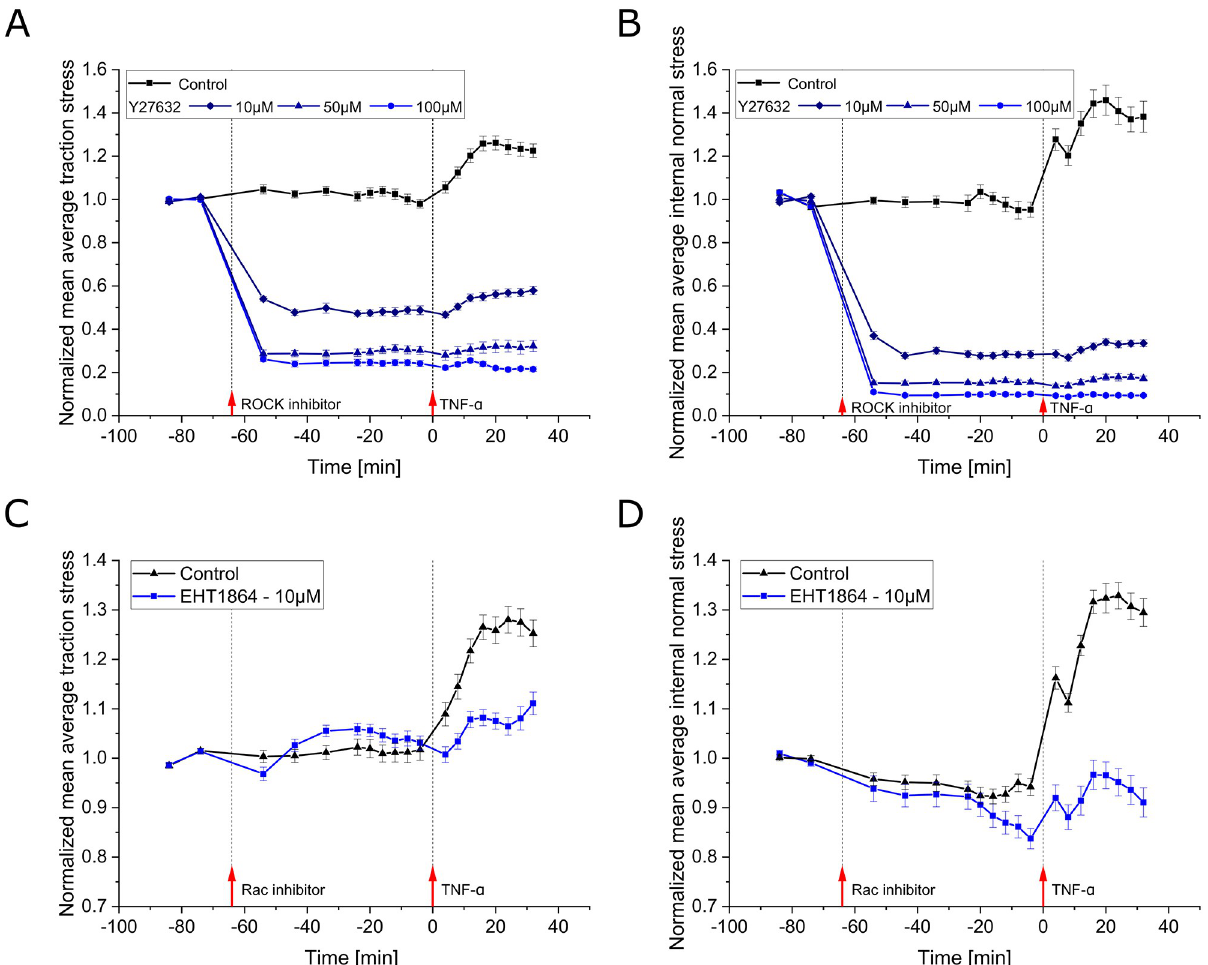
Fig 7. Effect of ROCK and Rac inhibitors on the mechanical response of HUVEC monolayers upon TNF- α stimulation. A,B : Time evolution of the mean of spatially averaged (A) traction stress and (B) internal normal stress of multiple monolayer islands for the control condition and 3 different concentrations of ROCK inhibitor (Y27632). Stresses were recorded at baseline, for about 1 h of ROCK inhibitor treatment and upon stimulation with 20 ng/ml TNF- α . Data is shown as mean ± SEM and has been normalized to the mean of the first 2 time points recorded prior to inhibitor administration for each individual monolayer island ( n ctrl = 12, n 10 = 10, n 50 = 7, n 100 = 11). Inhibitor treatment causes average stresses to drop μ M μ M μ M by more than 50%, reaching successively lower plateau levels with increasing concentrations. The response to TNF- α is progressively attenuated and rendered essentially undetectable for the highest concentration. Interestingly, the initial peak in internal normal stress observed in the control condition, which occurs due to the administration process, is nonexistent even at the lowest applied inhibitor concentration. C,D : Same as A and B, respectively, but for the application of the Rac1 inhibitor (EHT1864) instead of ROCK inhibitor and for only a 10 μ M concentration. Three independent experiments were conducted for both control and inhibitor conditions, both recorded on the same day for the same batch of cells, respectively ( n ctrl = 33, n 10 μ M = 33). Average stress levels are only slightly disturbed by Rac1 inhibitor treatment. The response to TNF- α , however, is reduced to an amplitude similar to that observed in the ROCK inhibitor pre-treatment